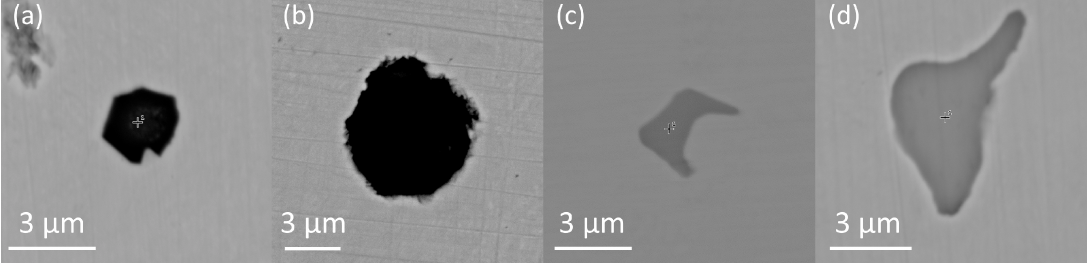
Figure 3. Scanning electronic microscopy (SEM) micrographs of typical inclusions: ( a ) Mg-Al-O; ( b ) Al-Ca-O-S; ( c ) TiN; ( d ) MnS. Table 3. Mechanical properties of the steel matrix and the inclusions in the martensitic steel